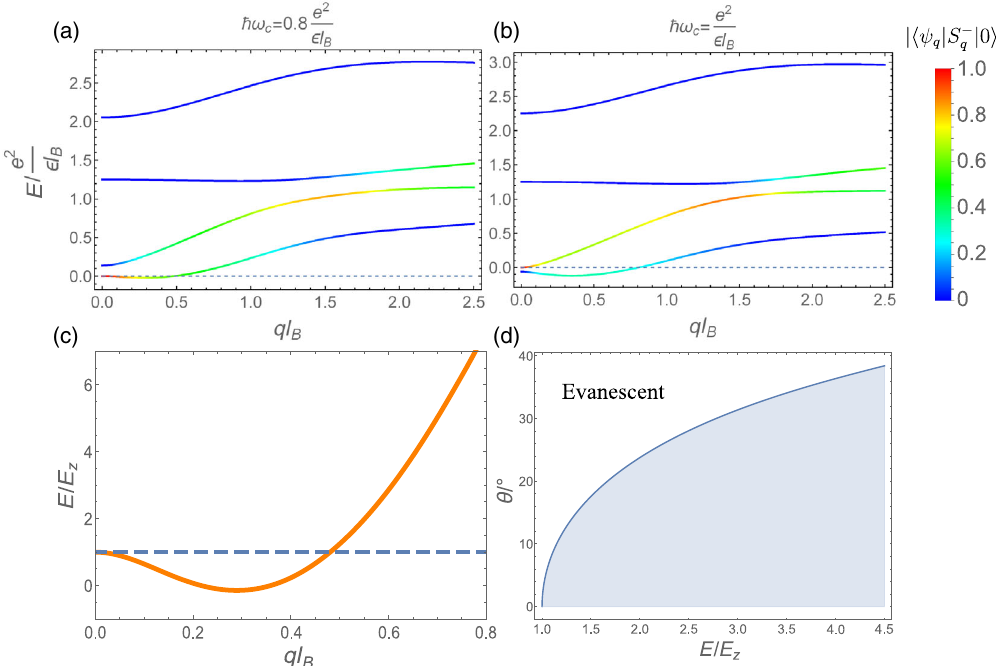
0 . 8 e 2 = ϵ l and c ¼ B 0 i , which is exactly one for the q ¼ 0 q j